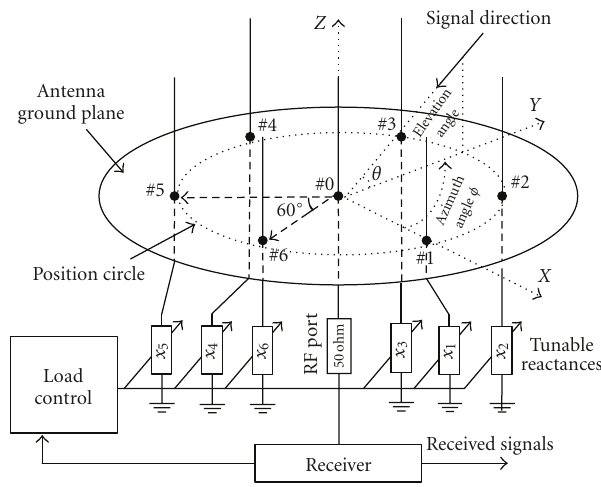
Figure 1: Structure of a 7-element ESPAR antenna. The elements are monopoles with interelement spacing of a quarter